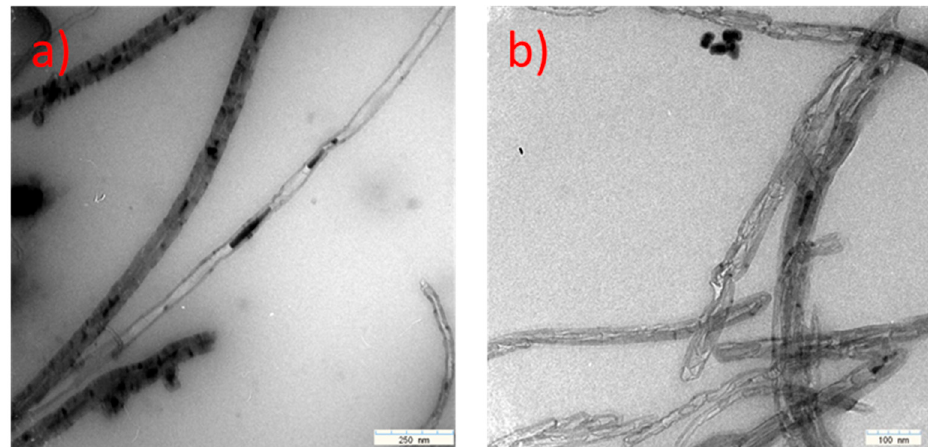
Figure 12. Transmission electron microscopy (TEM) images of Multi-Walled Carbon Nanotubes (MWCNTs) obtained during synthesis at ( a ) 1050 K; ( b ) 1070 K, respectively.